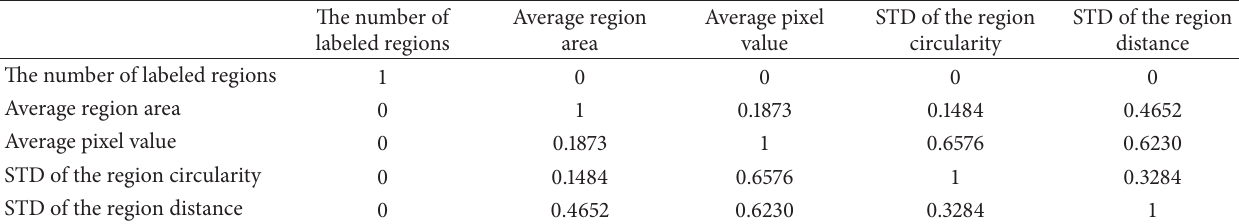
Table 1: The estimated 𝑃 value of the difference significance between the features.